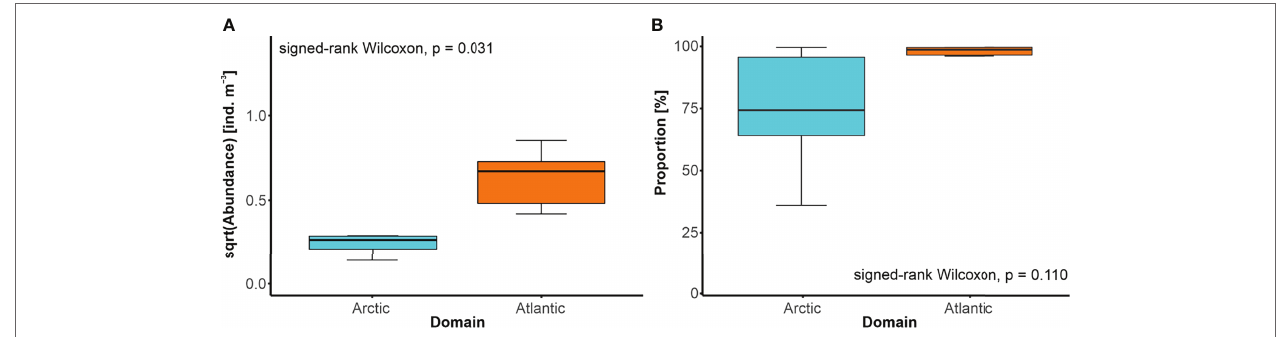
FIGURE 7 | Modifications of the GZ community related to the shift in the front position. (A) Abundance of the GZ and (B) median proportion of Aglantha digitale [%] in the GZ abundance, on sites before and after the change in their affinity from the Arctic domain to the Atlantic domain, and vice versa , with the results of the Wilcoxon signed-rank